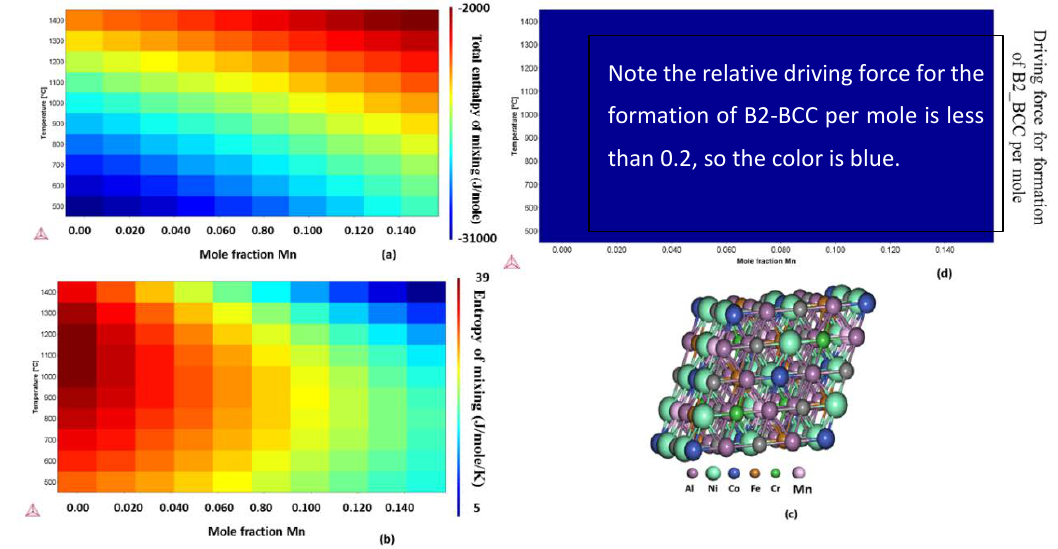
Figure A4. Role of Mn on the thermodynamic stability of HEA AlCoCrFeNiMn ( a ) Total enthalpy of mixing (J/mole) ( b ) Entropy of mixing (J/mole/K) ( c ) Optimized BCC lattice ( d ) Driving force for formation of B2_BCC per mole of AlCoCrFeNiMn.